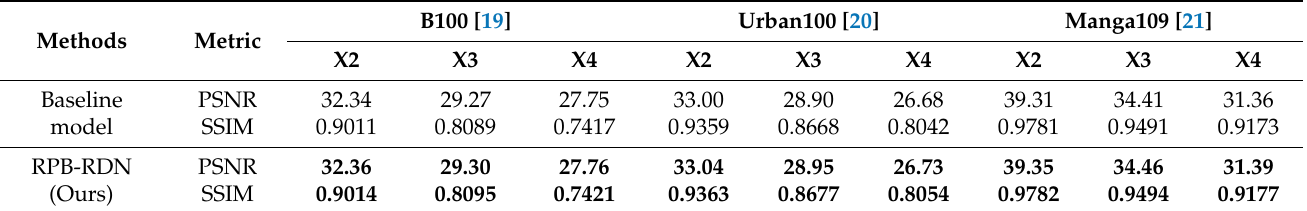
Table 1. PSNR (dB) and SSIM performance on proposed regularized pattern extraction network. The best performance is highlighted in the bold format.